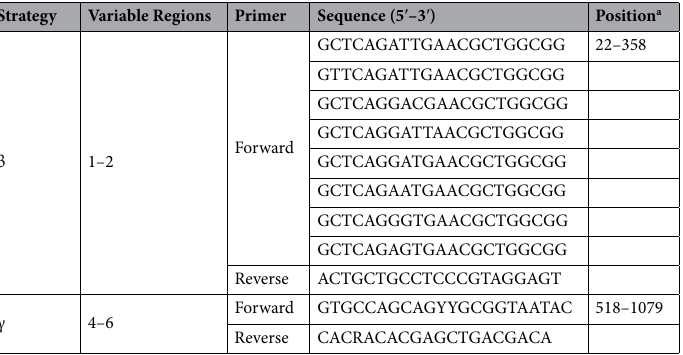
Table 3. Primers used for this study. a Based on numbering from gene rrsH accession number AE014075 from E. coli CFT073 complete genome NCBI reference sequence: